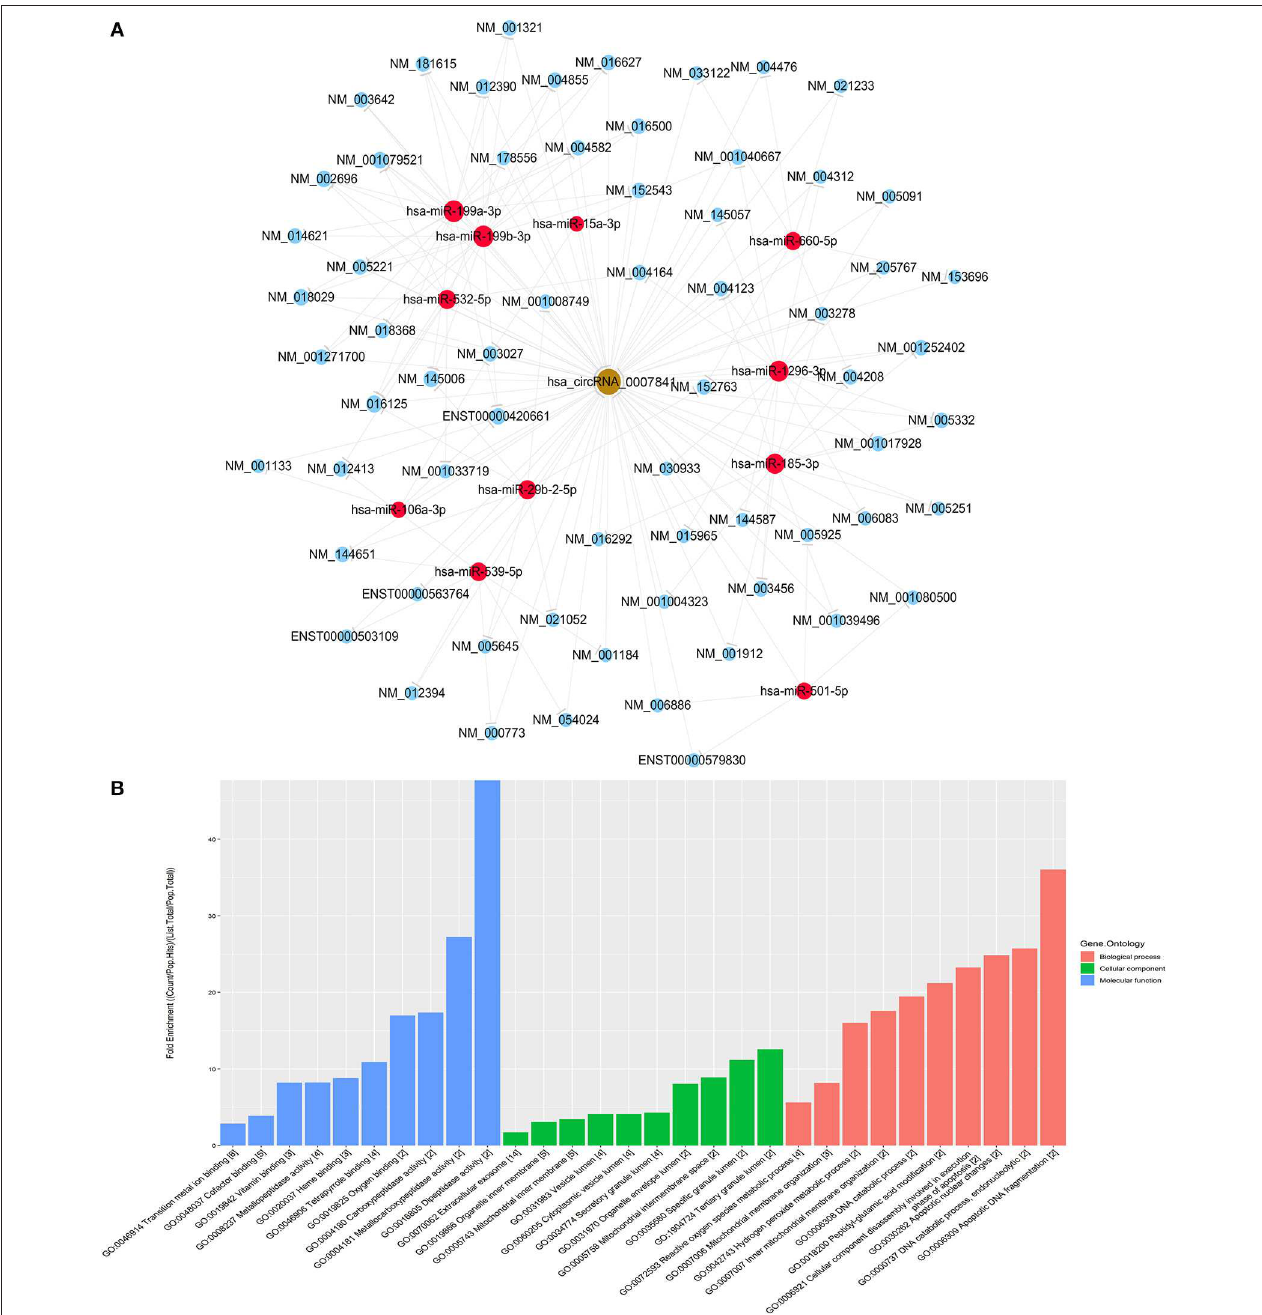
FIGURE 4 | Functional analysis of circRNA. (A) hsa_circ_0007841-miRNA-mRNA co-expression network established using hsa_circ_0007841. (B) The GeneOntology_Fold Enrichment. the factor of treatment, they can be used to guide individualized therapy. It has been shown that some genetic mutations are closely related to the poor outcome of MM, including chromosomal alterations t (4; 14), t (14; 16), and t (14; 20). Due to chromosomal translocation, oncogenes such as MMSET/FGFR3, CCND3, CCND1, MAF, and MAFB are still regulated by the IgH gene enhancer and their expressions increase (11, 32). As